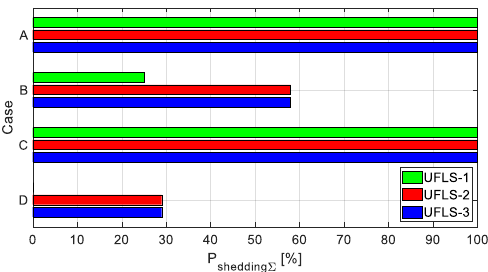
Figure 9. Total value of the disconnected power during the shedding process for the considered cases.